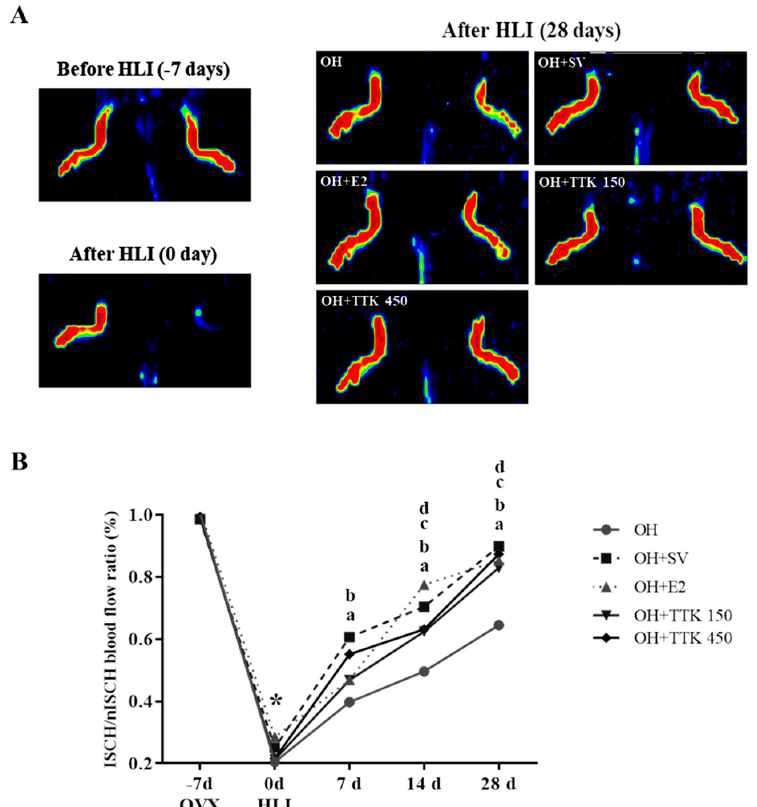
Figure 4. Effects of TTK on the blood perfusion in ischemic limb. ( A ) in color-coded images, low to no flow was displayed as black or deep blue whereas high blood flow was as yellow to red. Isch-L = ishchemic limb. nIsch-L = Non ischemic limb. ( B ) Quantitative evaluation of ischemic/non-ishcemic blood perfusion ratio. Values are presented as means ± SD (n = 7). * p < 0.05. vs.